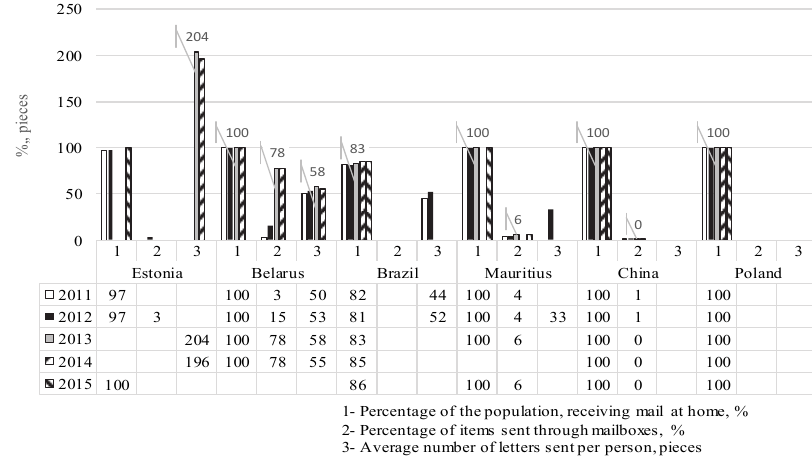
Fig. 2. Ranking of developing countries-leaders of different regions on the mail performance indicators